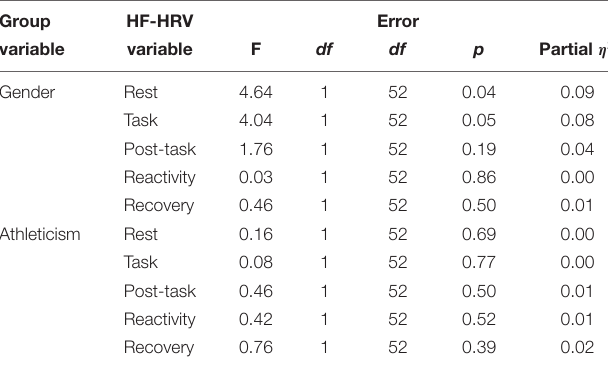
TABLE 5 | Between subjects